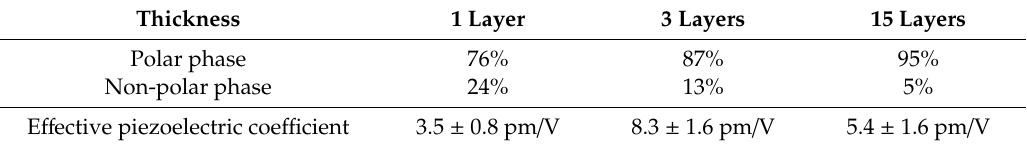
E ff ective piezoelectric coe ffi